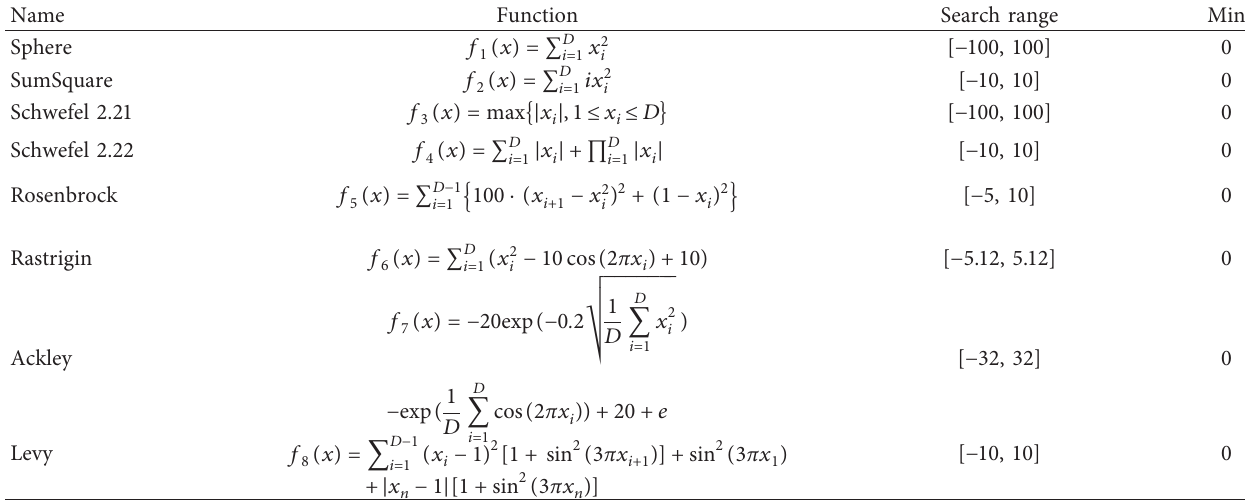
Table 1: Details about benchmark functions.